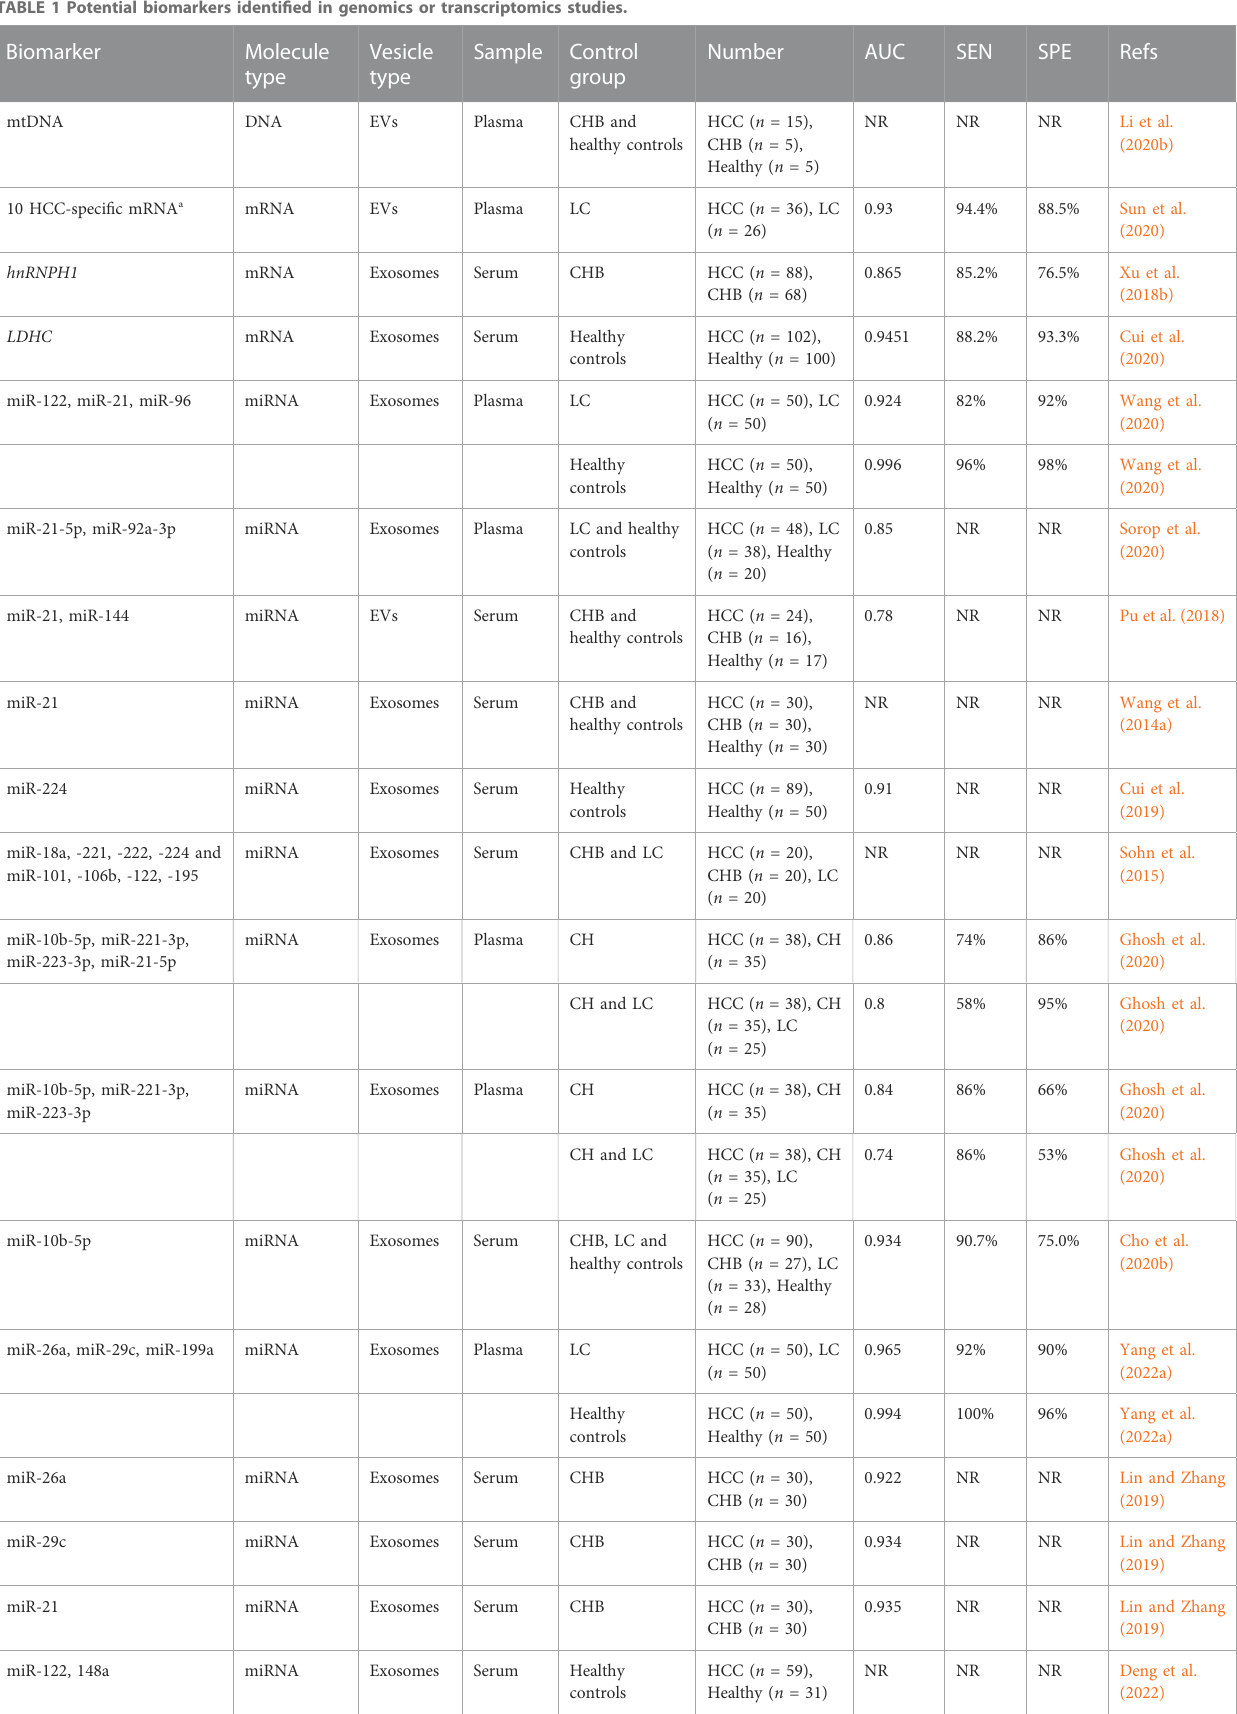
TABLE 1 Potential biomarkers identi fi ed in genomics or transcriptomics